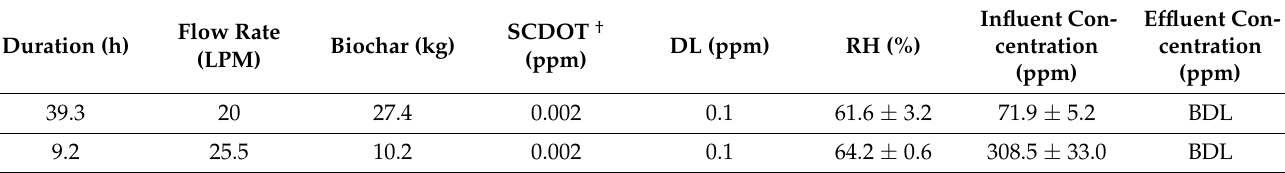
Figure 5. Daily sum of influent and effluent SCOAVs. Table 4. Process conditions for PSBORS for H 2 S